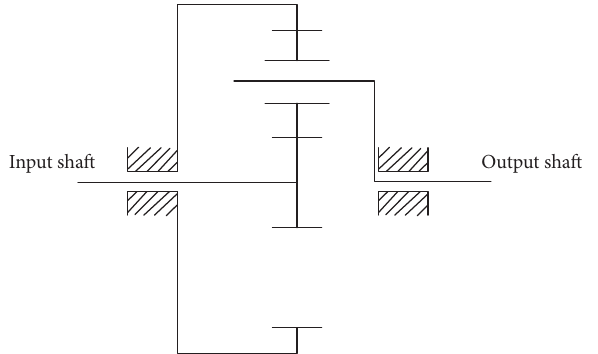
Figure 1: Schematic diagram of 2 Z - X planetary gear